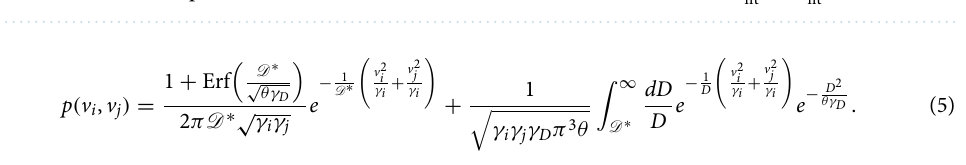
Figure 2. Avalanche statistics generated by the model at D ∗ 1 and γ i 15 and θ 0.05 for the extrinsic model. ( a – b ) Comparison between the trajectories γ D γ = = = = of D ( t ) , v i and the corresponding discretization in the low- D ∗ regime for ( a ) the extrinsic model and ( b ) the interacting one. ( c – d ) Same, but in the high- D ∗ regime. ( e – g ) If D ∗ is low, avalanches are power-law distributed with almost identical exponents in the extrinsic and interacting model, τ ext 1.77 0.01 , τ int 1.74 0.01 . The crackling-noise relation is verified in both cases. ( h – j ) Same and τ t = t = ± ± plots, now in the high- D ∗ regime. Avalanches are now fitted with an exponential distribution. Notice that